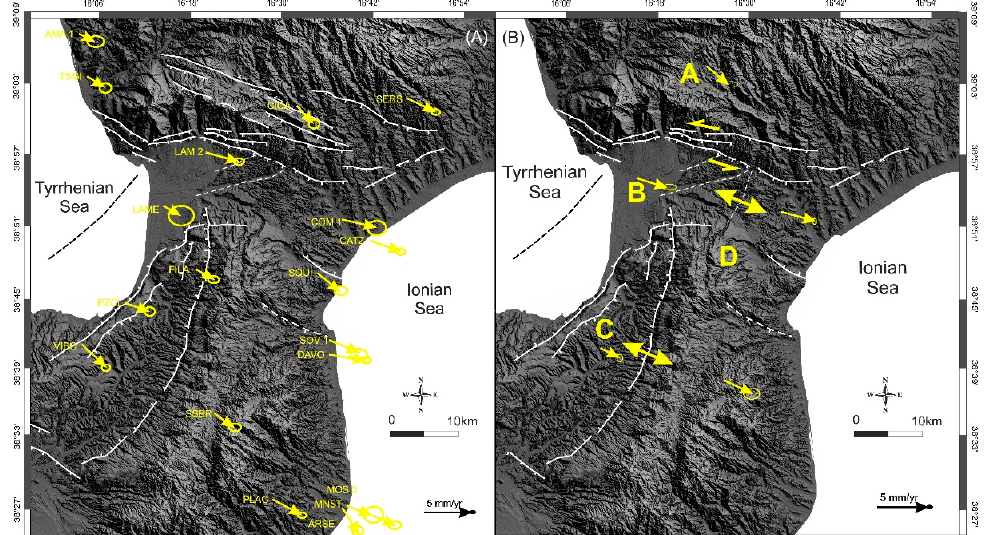
Figure 8. ( A ) Velocity field map of Catanzaro Trough. Velocities are referred to the Hyblean plateau [68]; ( B ) Velocity field map of the structural blocks and kinematics of the shear zones separating them.